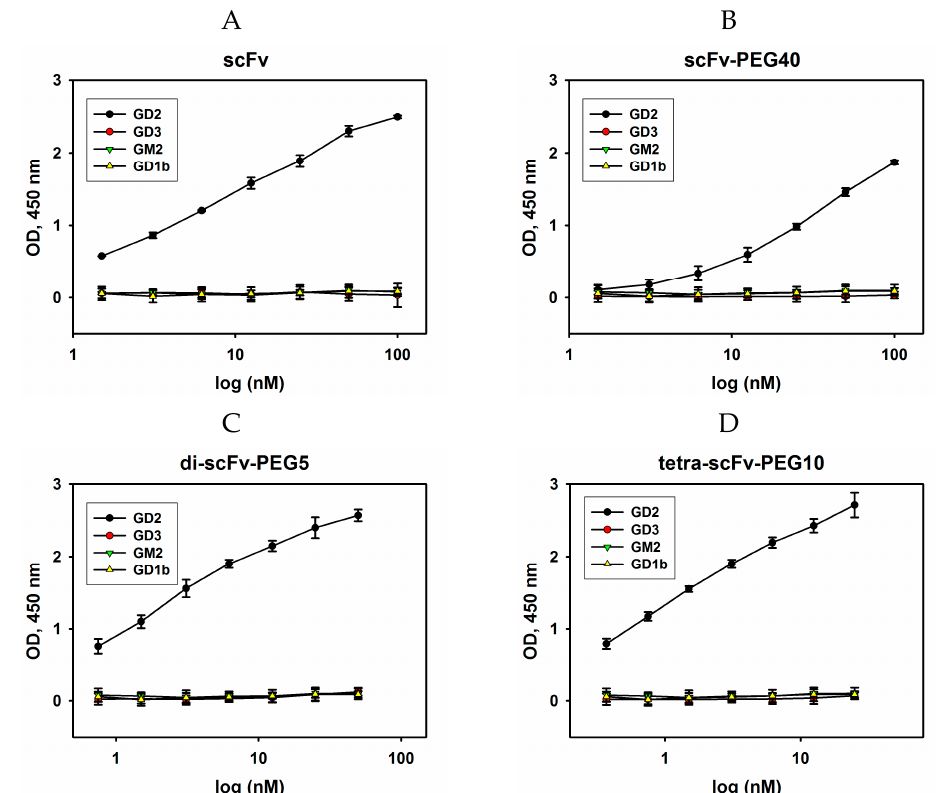
Figure 5. Evaluation of cross-reactivity of intact and modified scFv fragments in direct ELISA. GD2, GD3, GM2, and GD1b gangliosides were adsorbed on the plate; serial dilutions of intact scFv fragments ( A ), scFv-PEG 40 kDa ( B ), di-scFv-PEG 5 kDa ( C ), and tetra-scFv-PEG 10 kDa ( D ) were added to the wells. After incubation with HRP-labelled anti-FLAG antibodies (1:6000), the reaction was developed by Ultra TMB-ELISA Substrate Solution. Data are represented as mean ± SEM.